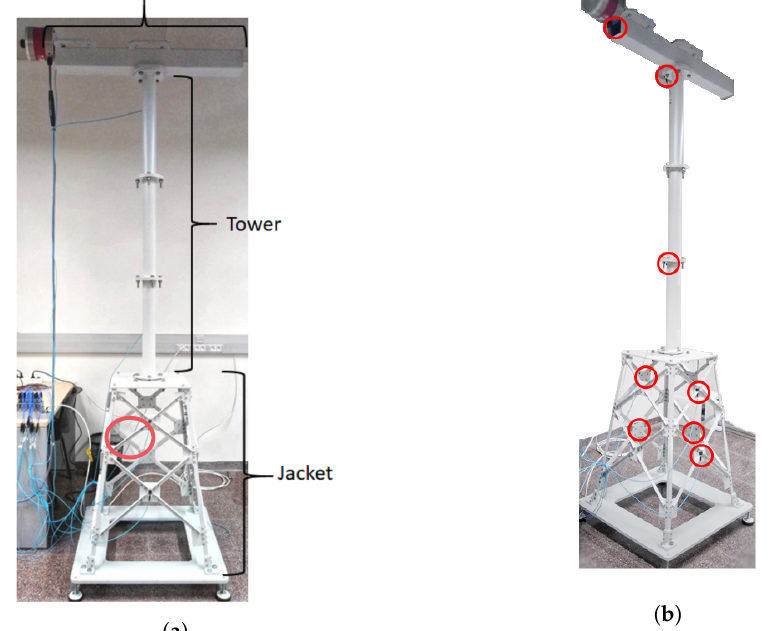
Figure 1. ( a ) The test bench detailing the location of the damaged bar (red circle); and ( b ) Location of the